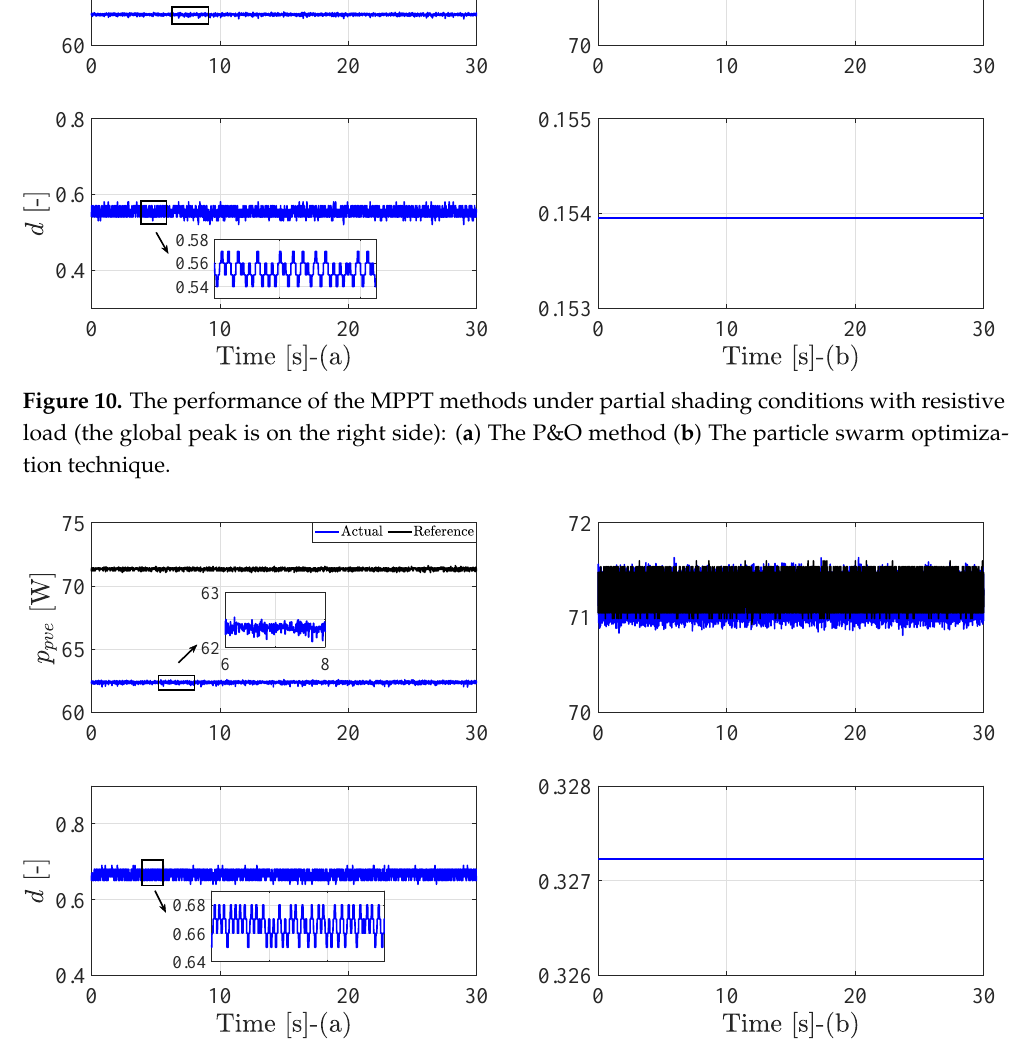
Figure 11. The performance of the MPPT methods under partial shading conditions with battery (the global peak on the right side): ( a ) The P&O method ( b ) The particle swarm optimization technique. Table 3. Average efficiencies of the MPPT techniques